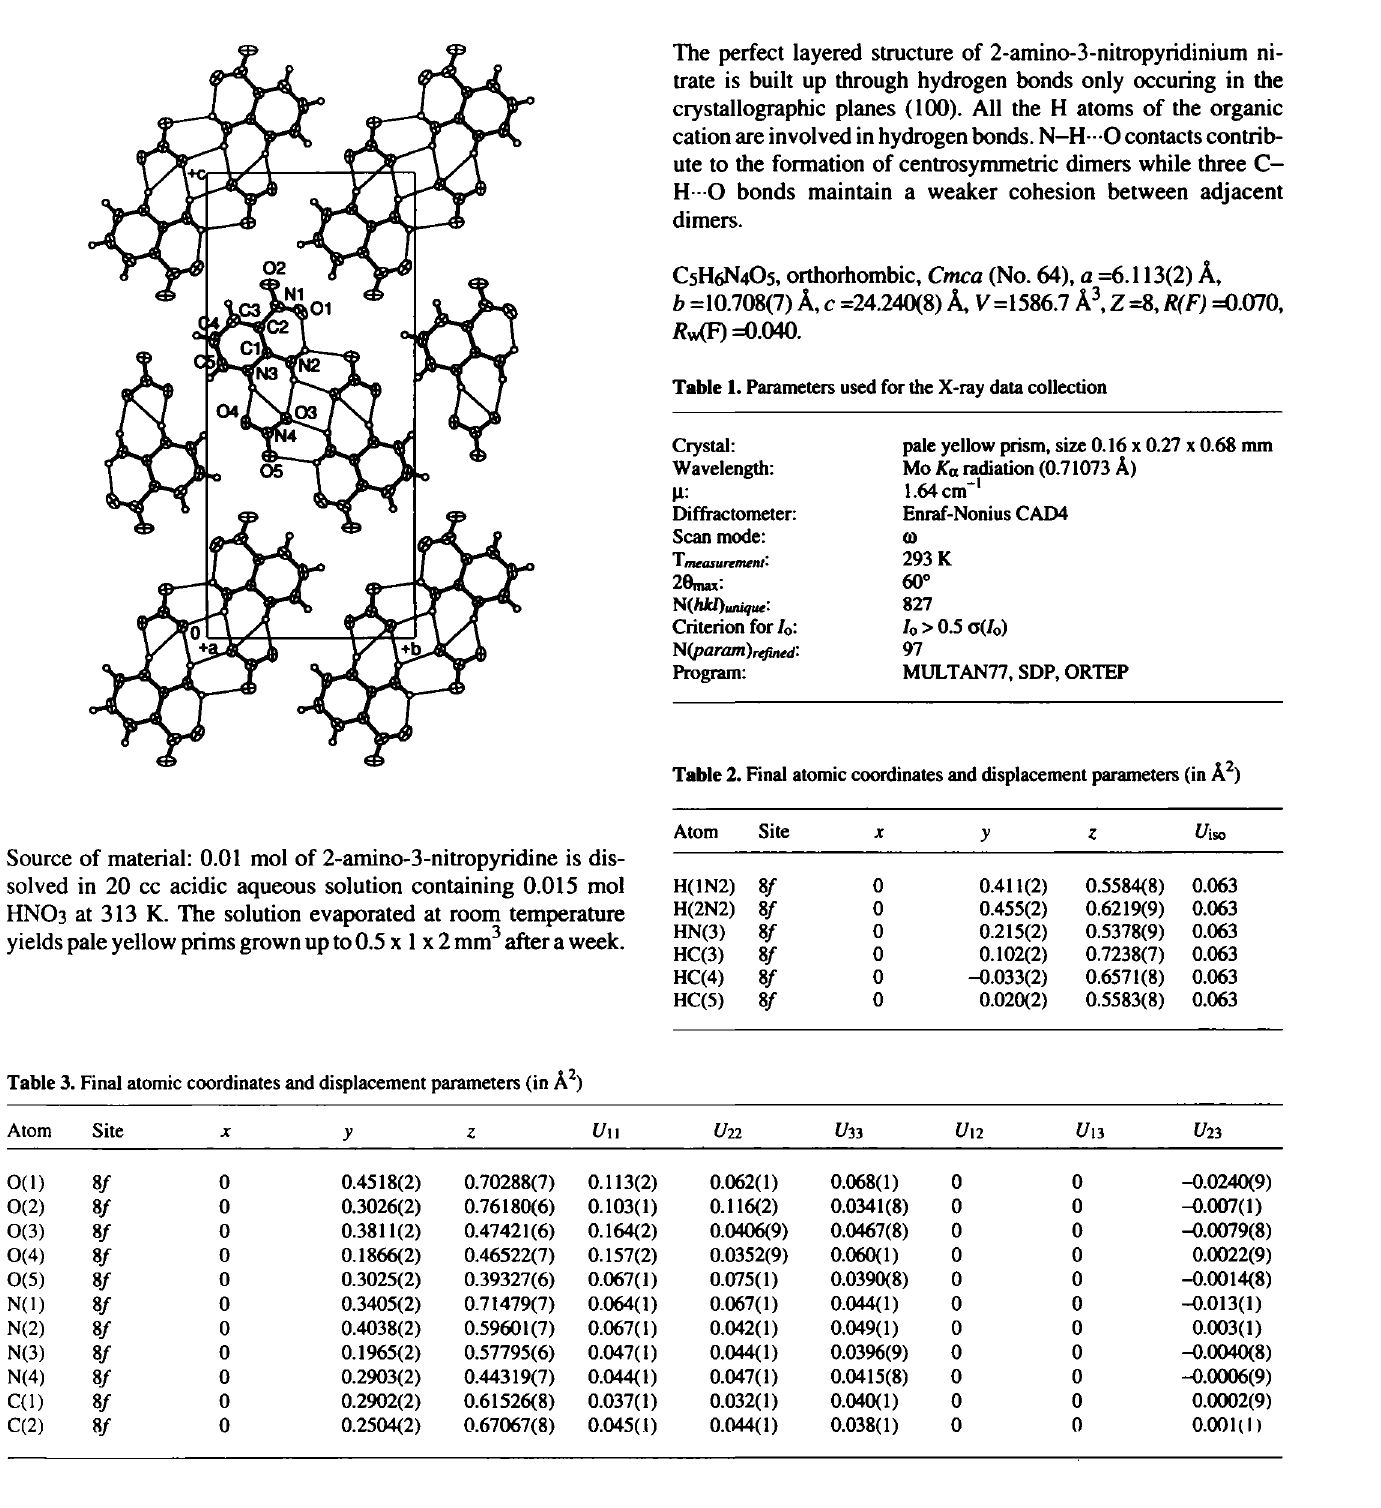
Table 3. Final atomic coordinates and displacement parameters (in